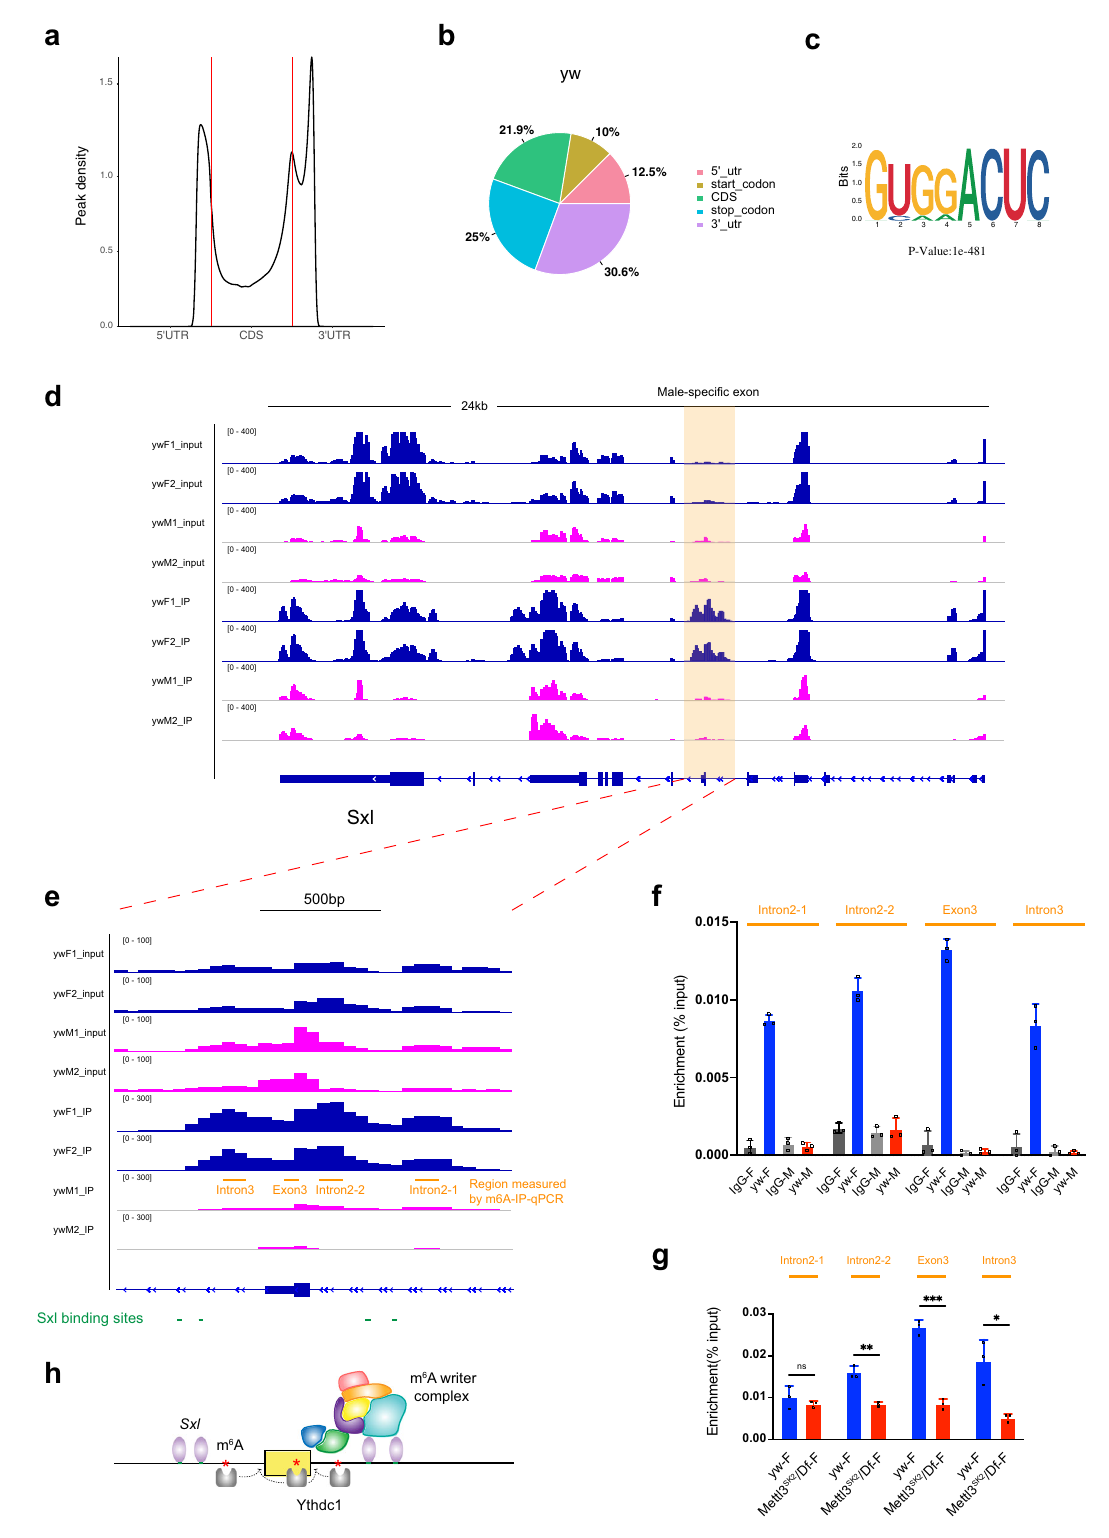
and for metabolic pathways in the KEGG analysis (Supplemen- tary Fig. 8d, e). By exhibiting MeRIP-seq together with RNA-seq data, we observed the reduction of m 6 A peaks in Mettl3 , Mettl14 , or Hakai mutant, and no obvious trend for change of mRNA expression correlated with differential m 6 A peaks (Supplementary Fig. 8f – h and Supplementary Data 5). We further divided the genes into m 6 A targets or nontargets, and the cumulative